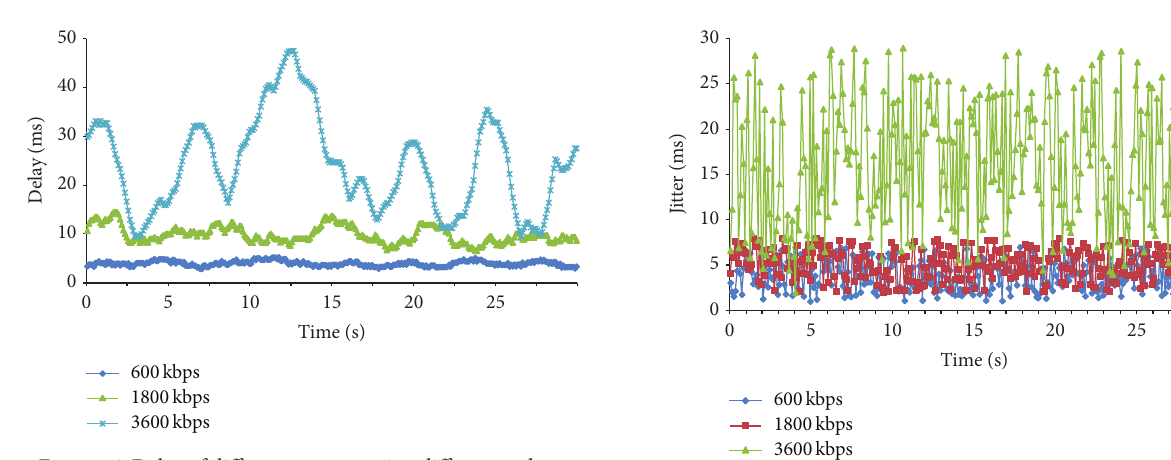
Figure 6: Delay of different streams using different codecs.